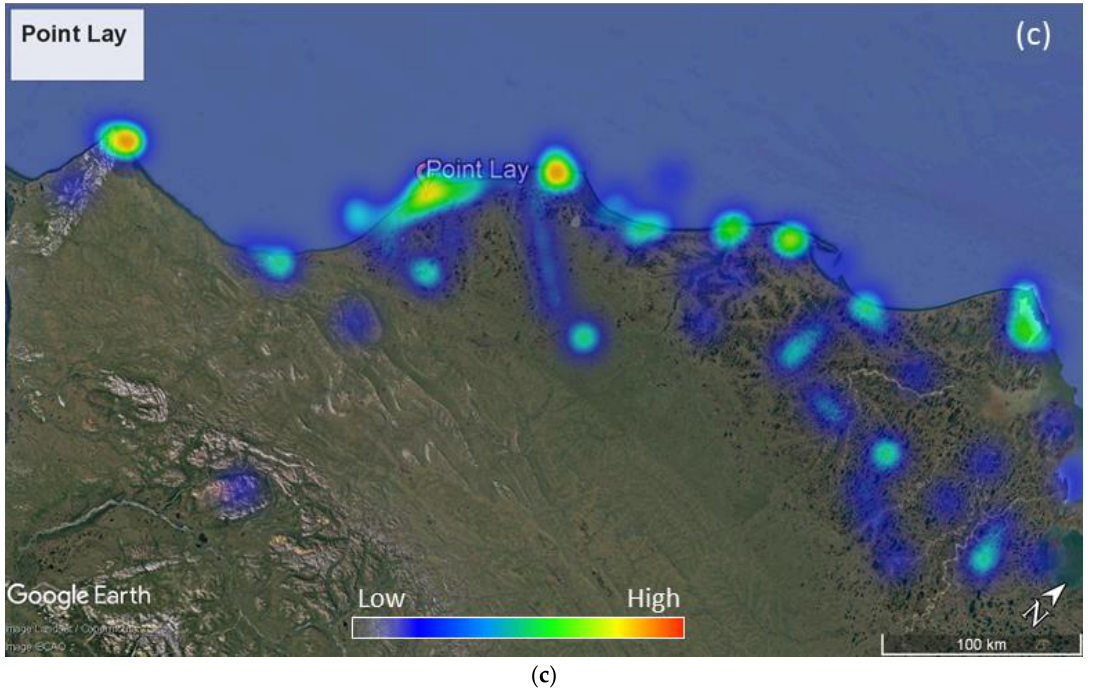
Figure 14. Heatmaps of permafrost degradation and coastal erosion in Point Lay: ( a ) 300 m, ( b ) 8 km, and ( c ) 100 km.